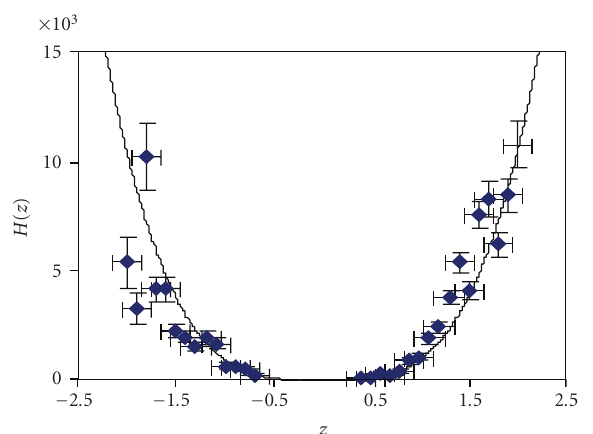
Figure 2: Probability density of hurricanes H ( z ) (times 1000) versus z computed from storm data in the Eastern Pacific basin (filled triangles) and for a latitude band of the Atlantic basin described in the text (open squares) for the period 1960–2007. Apart from three high z -points in the Eastern Pacific basin, the data are consistent with the n = 3 . 5 power law curve, but with 3.6 times the normalization used in Figure 1, solid curve. For clarity, error bars have been omitted for the Atlantic data